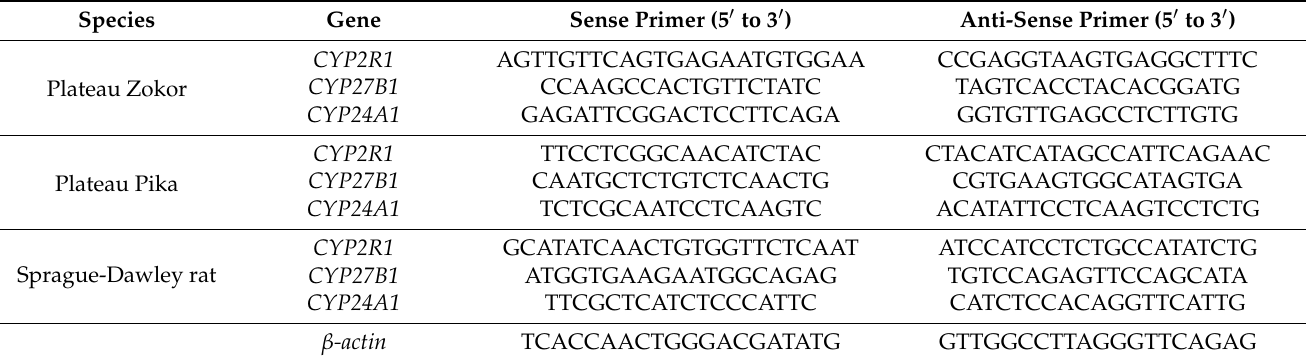
Table 1. Primers of vitamin D 3 metabolism-related genes and β -actin for qPCR. Species Gene Sense Primer (5 (cid:48) to 3 (cid:48)